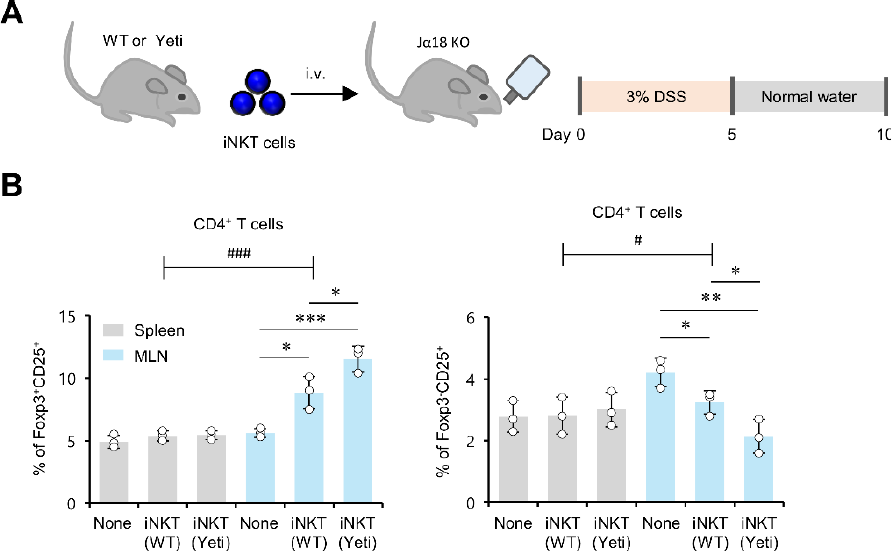
Figure 3. MLN iNKT cells play a critical role in regulating Foxp3 expression by CD25 + CD4 + T cells during DSS-induced colitis. ( A ) iNKT cell-deficient Jα18 KO mice were adoptively transferred with either WT or Yeti MLN iNKT cells (2 × 10 5 ) and subsequently treated with 3% DSS as described in Materials and Methods. ( B ) The frequencies of Foxp3 + CD25 + and Foxp3 − CD25 + subsets among CD4 + T cells in the spleen and MLNs from these mice were determined by flow cytometry on day 10. The mean values ± SD ( n = 3; per group in the experiment; Student’s t -test; * p < 0.05, ** p < 0.01, *** p < 0.001) are shown. Two-way ANOVA (Yeti × iNKT) showed an interaction between these two factors ( # p < 0.05, ### p < 0.001). One representative experiment from two experiments is shown.